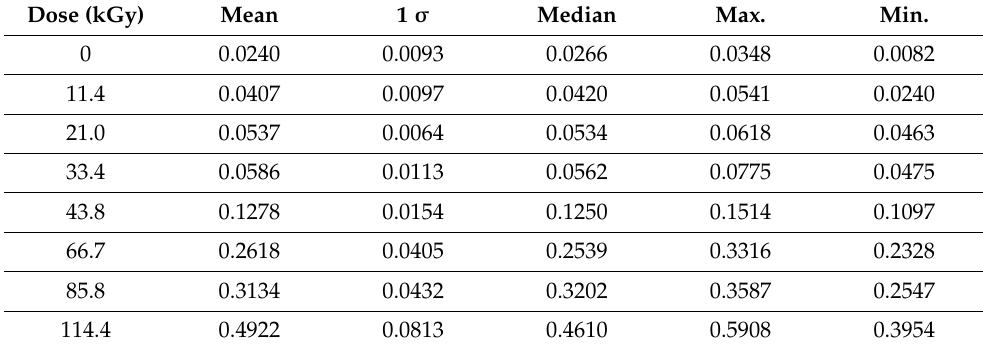
Table 8. Statistical analysis of the MLR of the PLA resins irradiated with an 11–120 kGy gamma dose. Dose